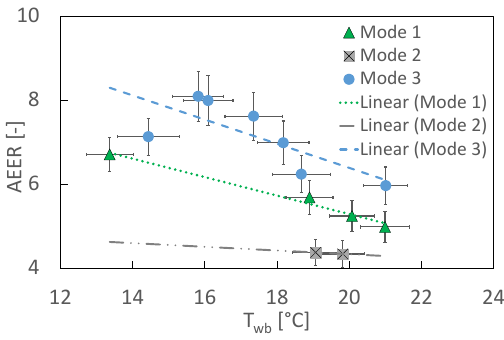
Figure 8. Daily performance of the three investigated control strategies (all